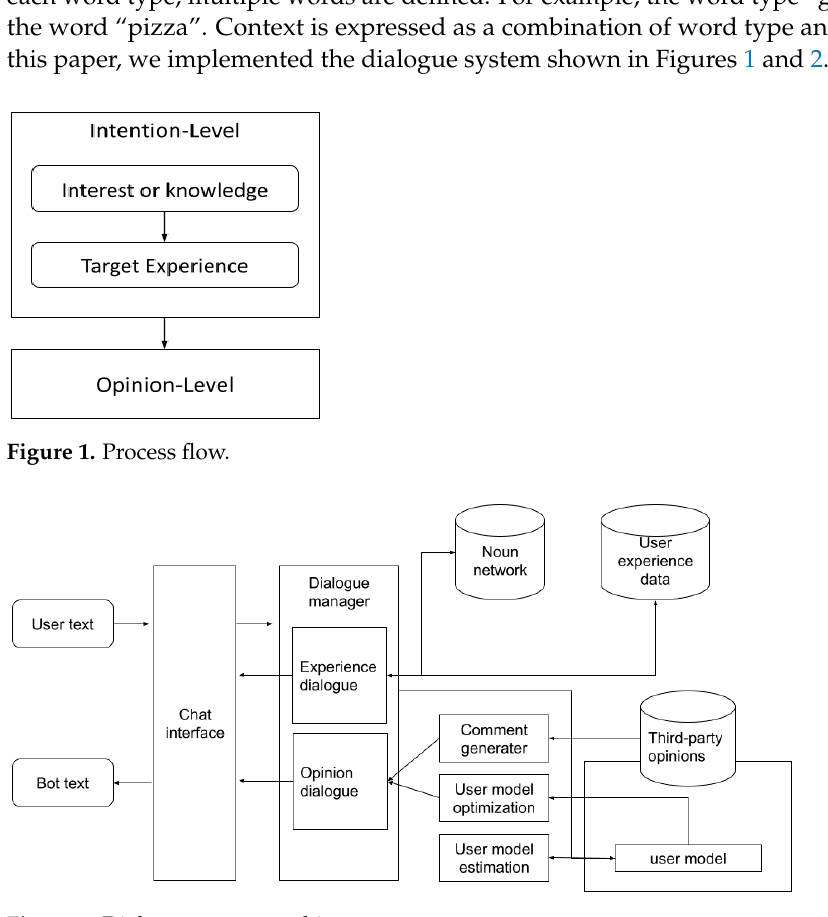
Figure 2. Dialogue system architecture.